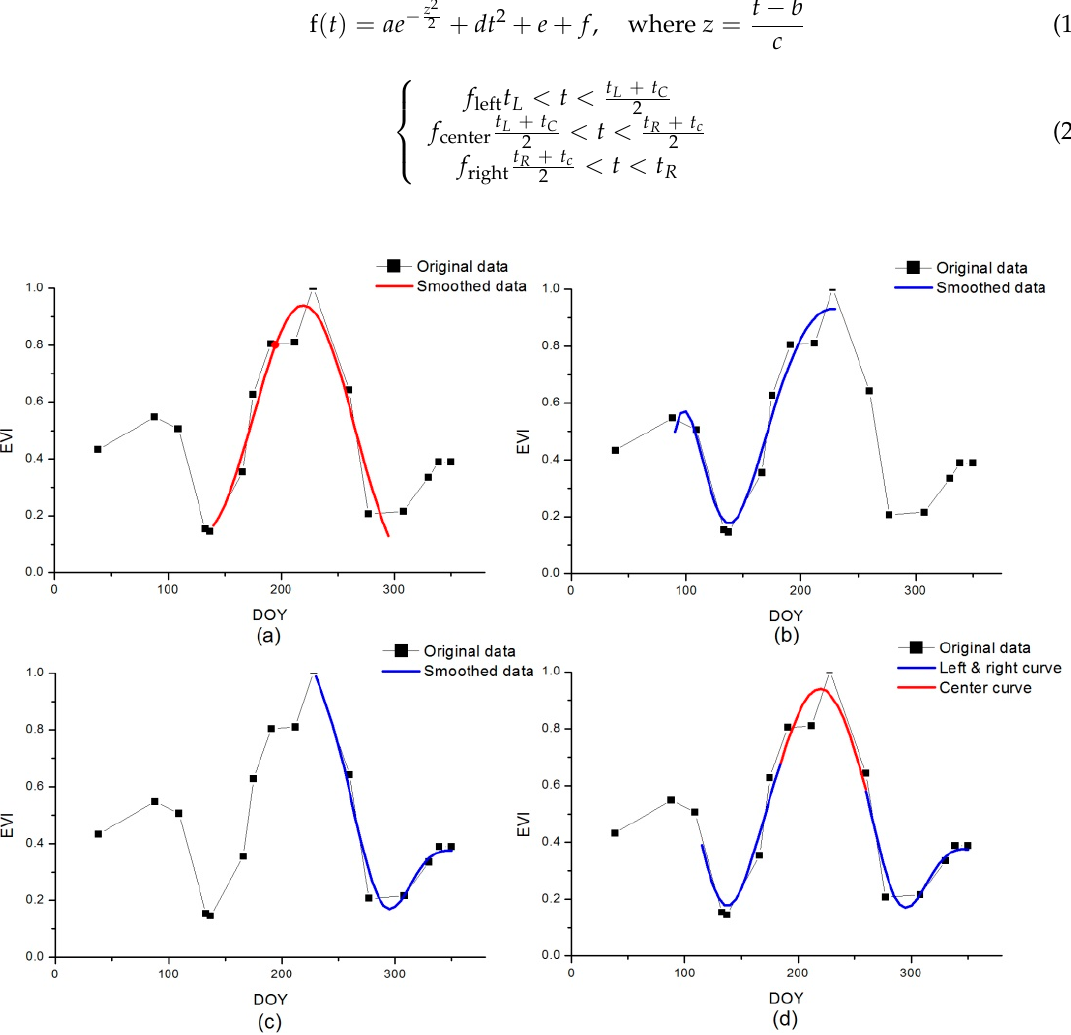
Figure 5. Piecewise Gaussian and Polynomial smoothing methods.